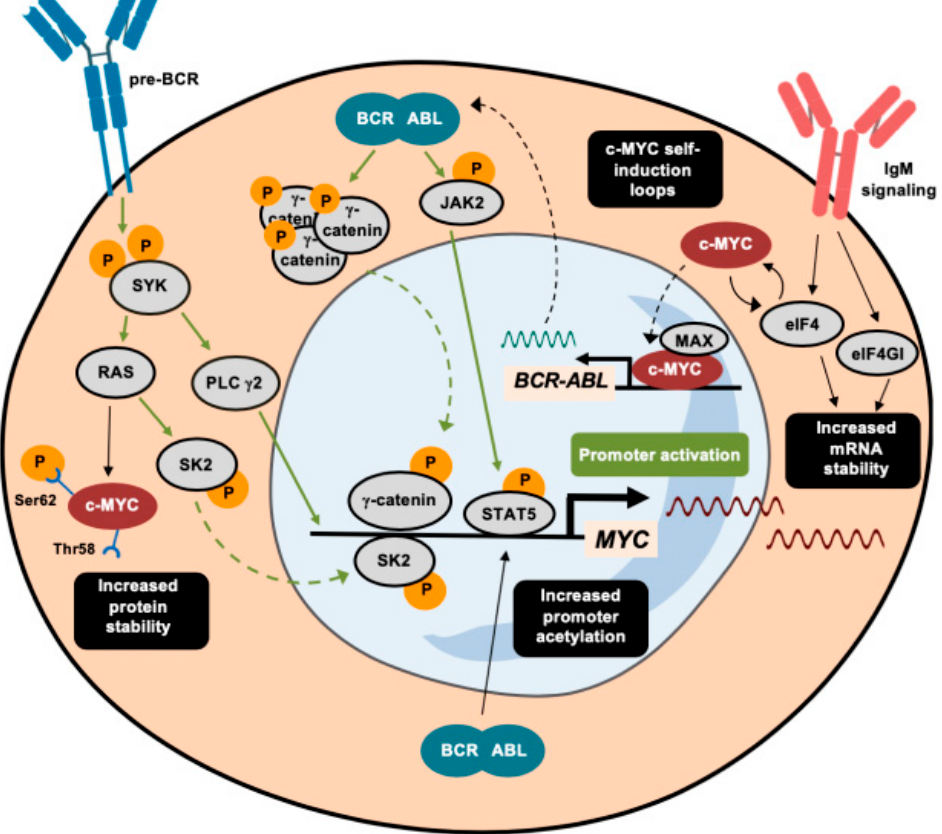
Figure 2. Activating mechanisms of c-MYC in leukemia with the BCR-ABL1 rearrangement. A summary of the different transduction signaling pathways that trigger the activation of MYC promoter in BCR-ABL1-rearranged leukemia. Apart from direct transcriptional activation pathways, marked in green, alternative mechanisms that induce c-MYC are depicted in black and highlighted in black squares. Dashed arrows indicate the translocation of proteins between the nucleus and the cytoplasm.